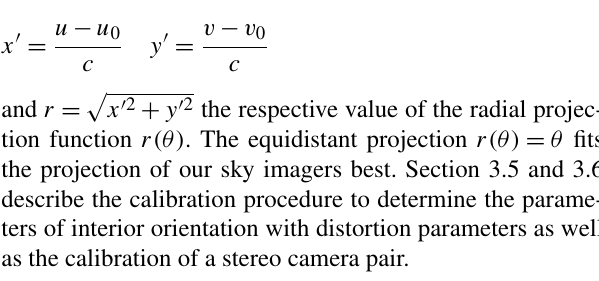
Figure 2. (a) In the omnidirectional camera model the 3-D ob- ject point P is mapped to x (cid:48) on the image plane. Several radial- symmetric projection functions r(θ) can be used, which define the distance to the projection center x C ; (b) the final projection x in pixel coordinates is determined by the camera calibration parame- ters and additional distortion